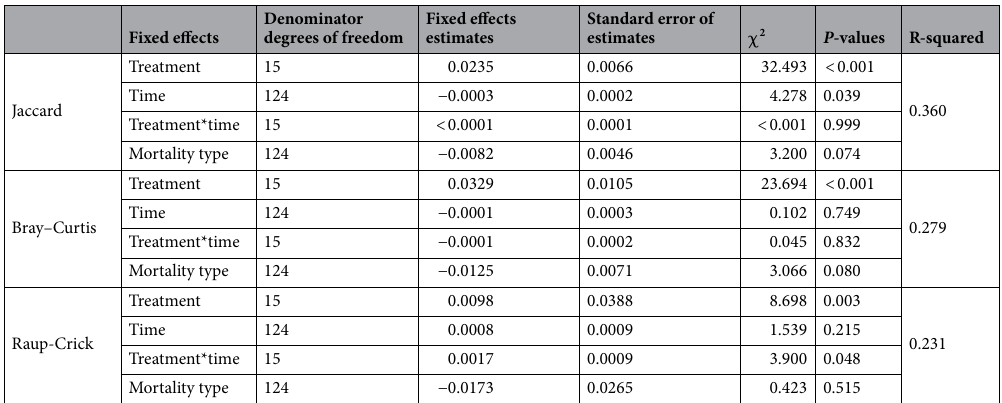
Table 1. Summary of LME models of multivariate dispersion. Each subsection represents a distinct community dissimilarity metric (Jaccard, Bray–Curtis, and Raup-Crick, respectively). Predictor variables included in the model are denoted in the Fixed effects column. All other columns detail model output including denominator degrees of freedoms, Wald chi-square values, and p -values for each fixed effect. Evaluation of the LMER models was conducted using type-II sum of